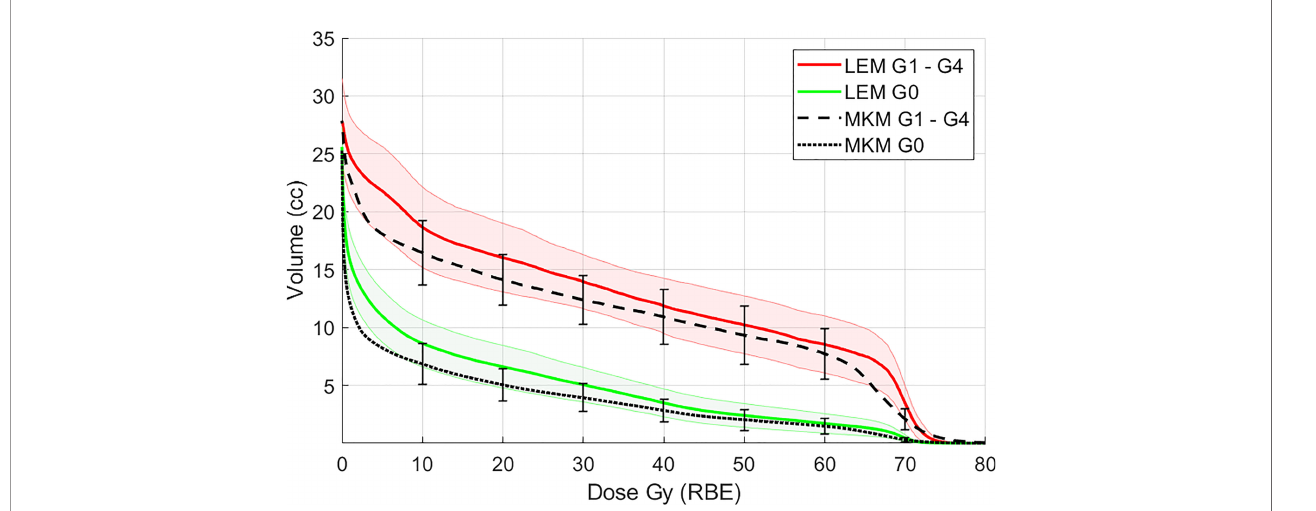
FIGURE 2 | Mean maxillary volumes at incremental dose levels from 10 to 60 Gy (RBE) calculated with the LEM model in patients with ORN (G1 – G4, red solid line) vs patients without ORN (G0, green solid line). In black the maxilla DVH averaged for all the patients for the MKM model is also presented. Shaded bands and vertical error bars represent 2 SEM (Standard Error of the Mean) for the LEM and MKM model, respectively.